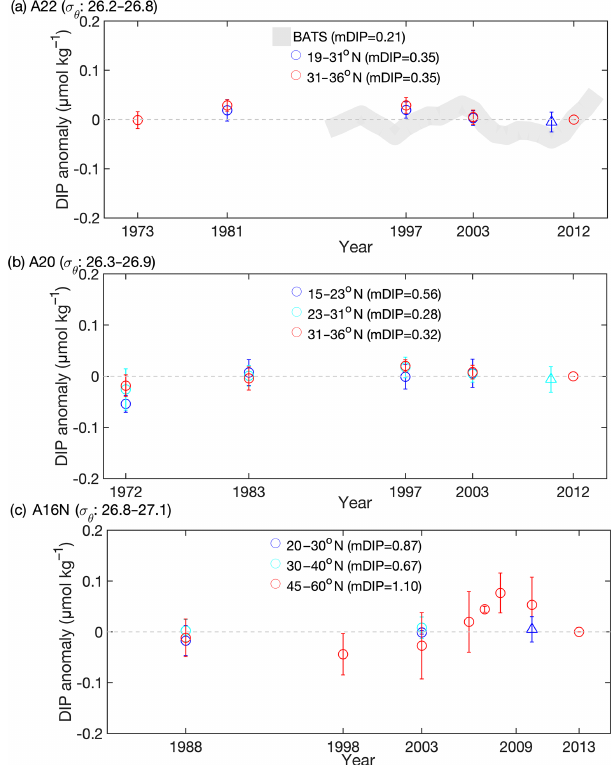
Figure 4. As for Fig. 3 but for DIP anomalies. mDIP values in parentheses indicate the mean DIP in the GO-SHIP dataset. For each subregion, DIP anomalies indicate individual DIP values mi- nus the mDIP values from the GO-SHIP dataset. The gray dashed lines indicate that the DIP anomaly equals to zero. Data from the BATS site are also included in (a)